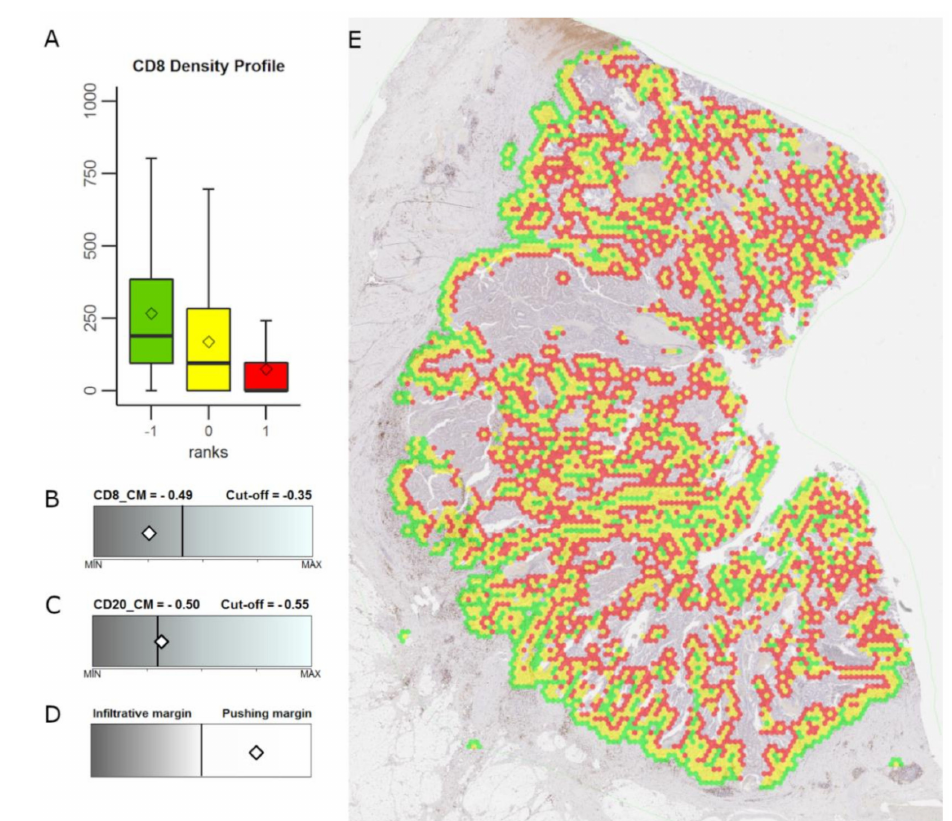
Figure 2. Example of extracted tumor-stroma interface zone, Immunogradient indicator estimates and tumor growth pattern in an individual colorectal cancer case. ( A ): CD8 + cell density profile within the IZ, the box-plot colors correspond to the colors in ( E ); ( B , C ): CM for CD8 + and CD20 + cell density values, respectively, represented by a white diamonds within the range of the indicator values; ( D ): tumor growth pattern represented by a white diamond within the two-color bar indicating infiltrative versus pushing margins; ( E ): shows the interface zone overlaid on the whole slide image (see Figure S1 for the original image without the overlay): tumor edge (yellow), tumor aspect (red), stroma aspect (green). Prognostic cut-o ff values for the CRC patient cohort are represented by the vertical line within the range of the indicator values; the grey shade of the bar represents better prognosis for brighter values and worse prognosis for darker